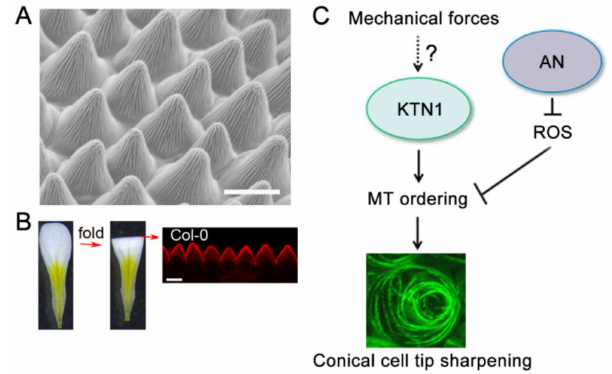
Figure 2. A working model for the regulation of conical cells tip sharpening. ( A ) The petal conical cells were viewed by scanning electron microscopy (SEM). Bar = 15 µ m. ( B ) The petal conical cells were viewed from a folded petal using confocal microscope. Bar = 10 µ m. This image was generated from Ren et al. [40]. ( C ) The AN-ROS and KTN1 pathways converge at a node to modulate microtubule ordering during conical cell tip sharpening. AN negatively regulates the level of reactive oxygen species (ROS) and then inhibits the ordering of microtubules, which in turn correlates with the tip sharpening of the conical cell. KTN1-dependent microtubule-severing promotes the formation of well-ordered microtubules and leads to conical cell tip sharpening. Visualization of microtubules in a conical cell from a transgenic line expressing GFP-TUA6 . Confocal image was generated by top-down 2D maximum projections of Z-stacks. The arrows indicate positive regulation, and the perpendicular lines indicate negative